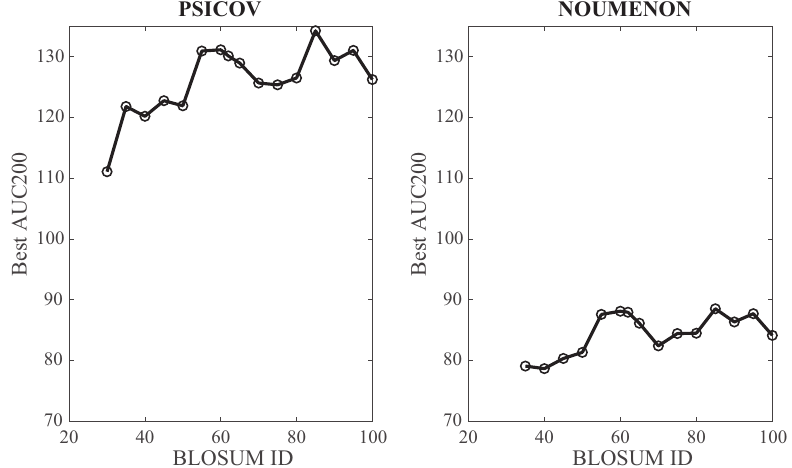
Figure 8. Influence of the BLOSUM matrix ID on the performance of GaussCovar based on BLOSUM encodings of amino acids. The optimal AUC200 (over all predicted contacts) for GaussCovar is plotted against the BLOSUM ID for the PSICOV dataset ( left ) and the NOUMENON dataset ( right